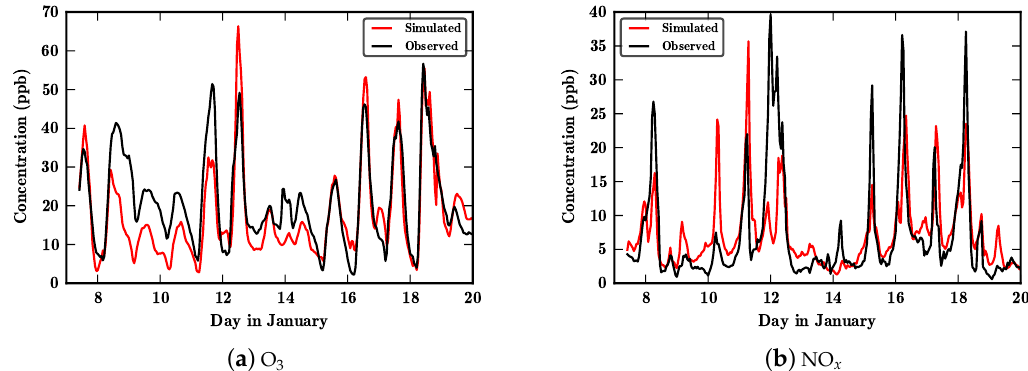
Figure 6. Timeseries of measured and simulated surface ozone and NO x averaged across 17 sites in Greater Sydney.